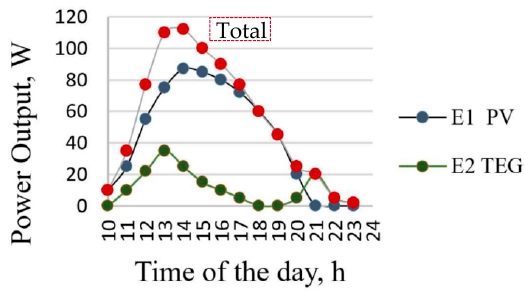
Figure 11. Combined power performance of PVT-3 on a typical summer day [61,62].